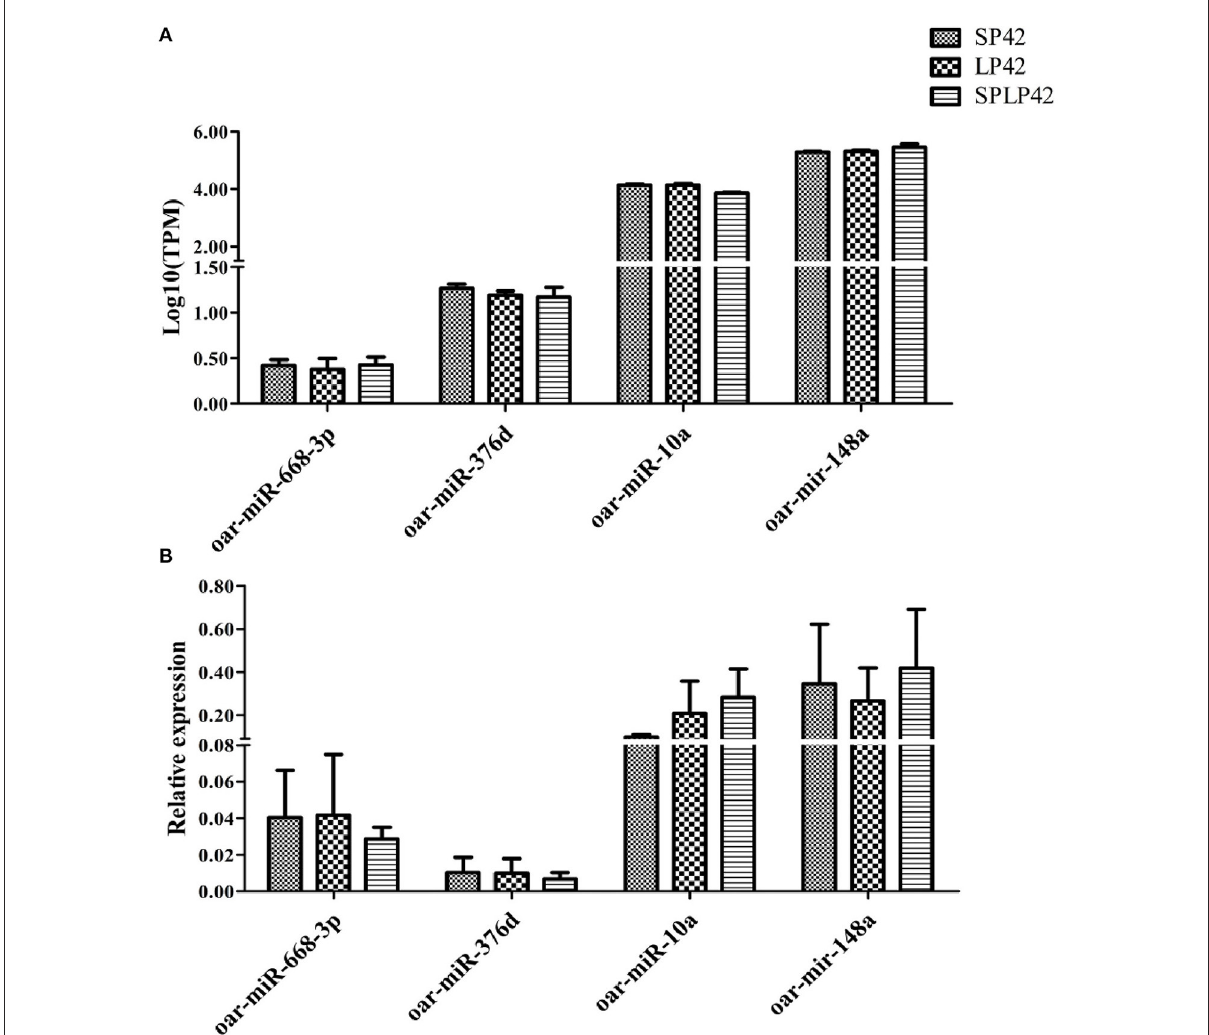
FIGURE7 Quantitative verification results of miRNA. The relative expressions of 4 miRNA randomly selected in different individuals and among comparison groups were verified. Rectangles with different patterns represent RNA-seq (A) and qPCR (B) results,